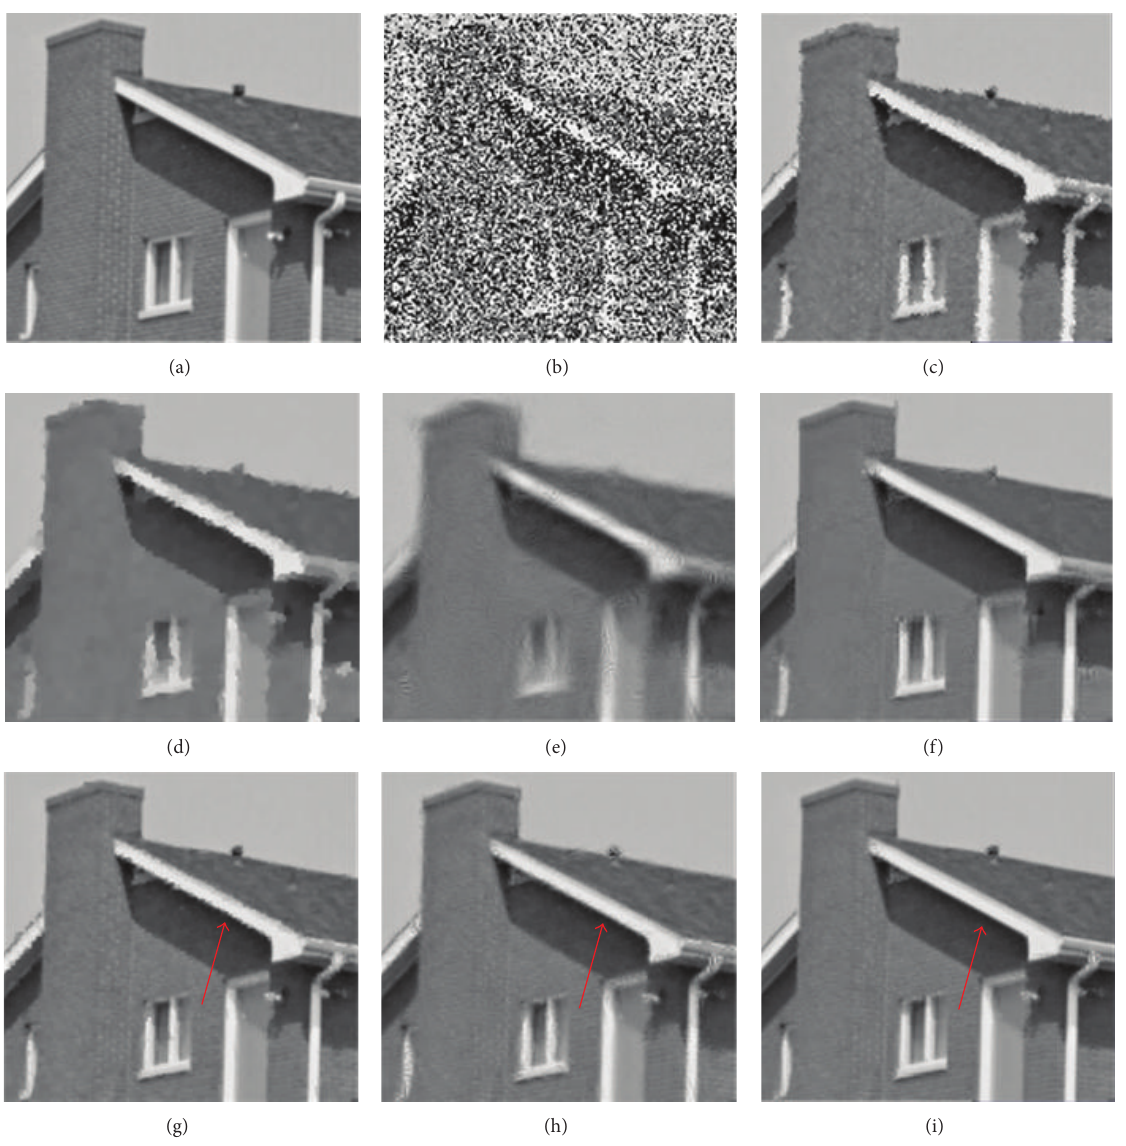
Figure 5: Reconstructed House images from 50% salt and pepper impulse noise. (a) Noise-free image, (b) noisy image, and (c)–(i) reconstructed images using AMF, TV, Wavelet, PANO, TV-ND, Wavelet-ND, and PANO-ND,